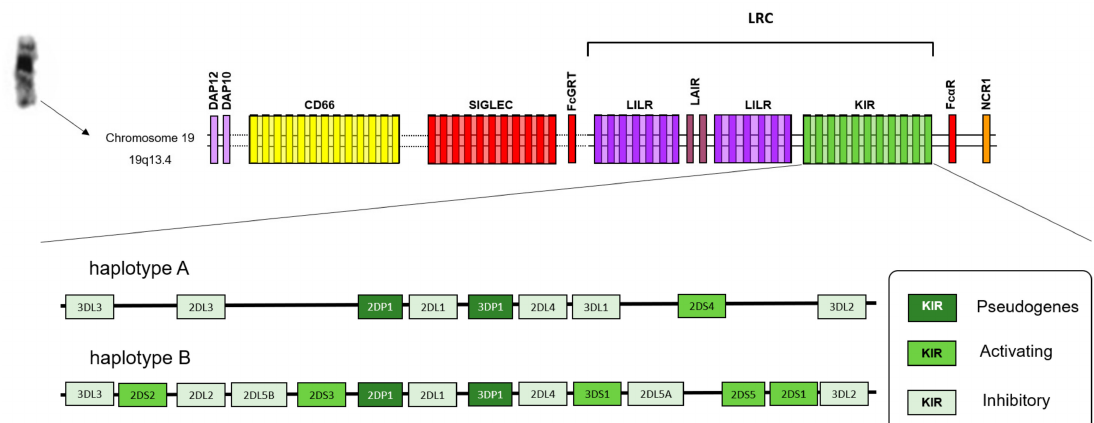
Figure 1. Schematic representations of the Leukocyte Receptor Complex (LRC) region and typical KIR a and B genotypes. Map of the Leukocyte Receptor Complex. The Leukocyte Receptor Complex (LRC) is formed by a cluster of genes that encode a family of proteins that contain immunoglobulin-like domains. These include the families “killer immunoglobulin-like receptors (KIR), “leukocyte immunoglobulin-like receptor” (LILR), and “leukocyte-associated immunoglobulin-like receptor” (LAIR). The “signaling lectins” (SIGLECs) and members of the family CD66 are found close to